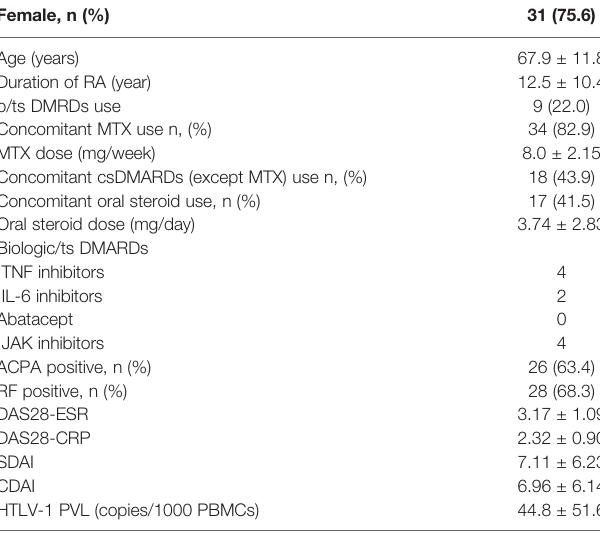
TABLE 1 | Clinical characteristics of the study